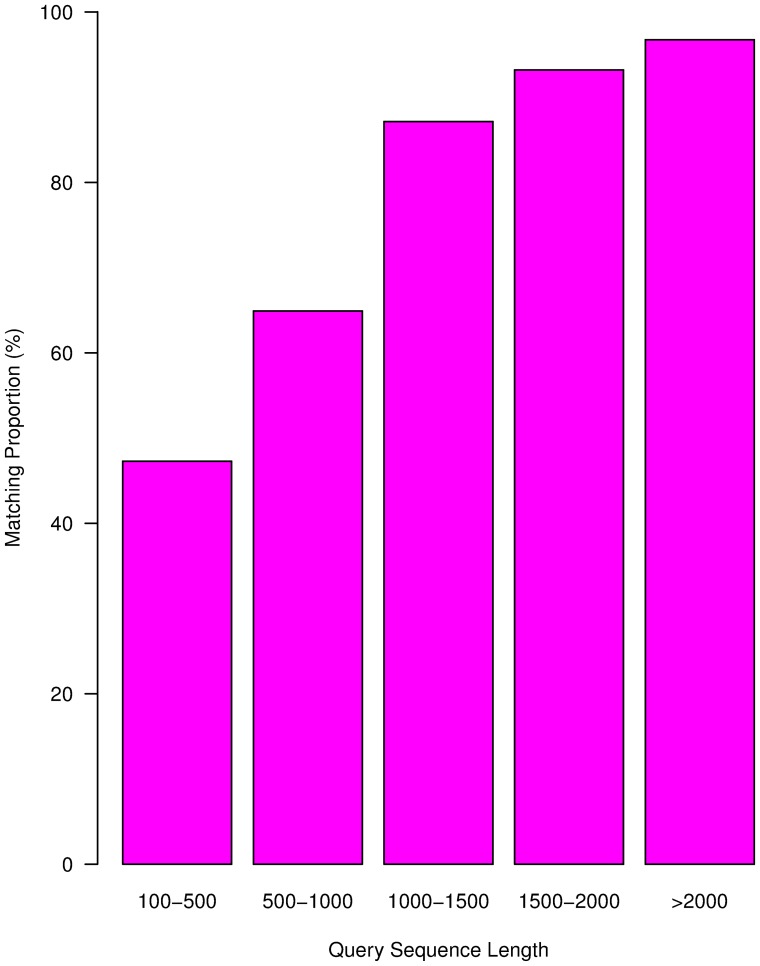
Matching percentage of D. latiflorus cDNA sequences with different lengths to entries in the GenBank databases.